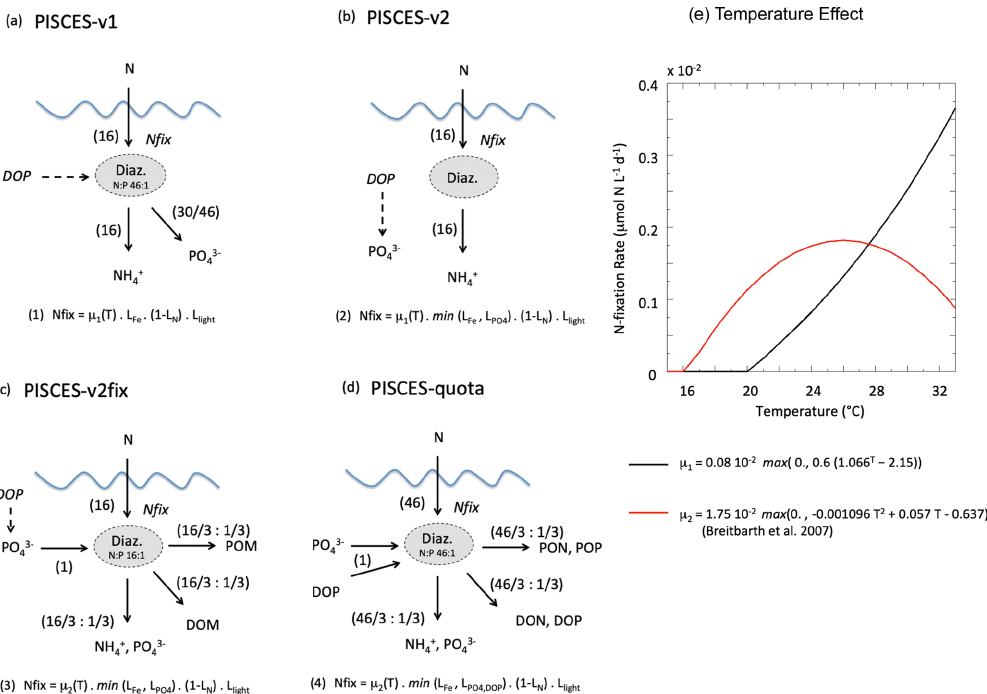
Figure 2. Schematic diagram describing the parameterisation of N fixation for each of the PISCES versions (a–d) used in this study. Equations (1) to (4) give N-fixation rates as a function of µ , the N-fixation rate at temperature T ; L PO (varying between 0 and 1) for phosphorus, iron and nitrogen, respectively; and L light a light limitation term (also between 0 and 1). The values in parentheses denote the number of moles (of nitrogen or phosphorus) that are consumed and produced by the implicit N-fixation parameterisation. (e) N-fixation rate (in µmolNL − 1 d − 1 ) as a function of water temperature and in the case of no other limitation, for PISCES-v1 and PISCES-v2 (black curve) and PISCES-v2fix and PISCES-quota (red curve, from Breitbarth et al., 2007). See text for details on the rationale for the different